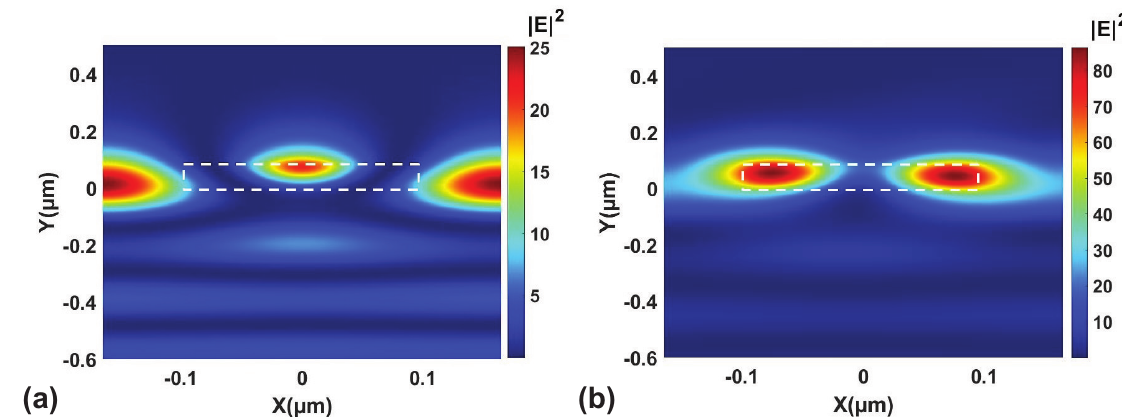
Figure 4. Cross section electric field profile at the reflection windows in Figure 1c at ( a ) 0 degrees at 538 nm and ( b ) 5 degrees at 613nm, respectively. The high index titanium dioxide region is labelled with a white dashed box. There are two branches dictated by the cutoff in Figure 3a. The field profile in ( a ) is localized outside the high index region while they are below the cutoff wavelength, representing the dual mode regime in the dispersion in Figure 3a. The field profile in ( b ) is localized inside the high index region as they are above the cutoff wavelength, representing the single mode regime in the dispersion in Figure